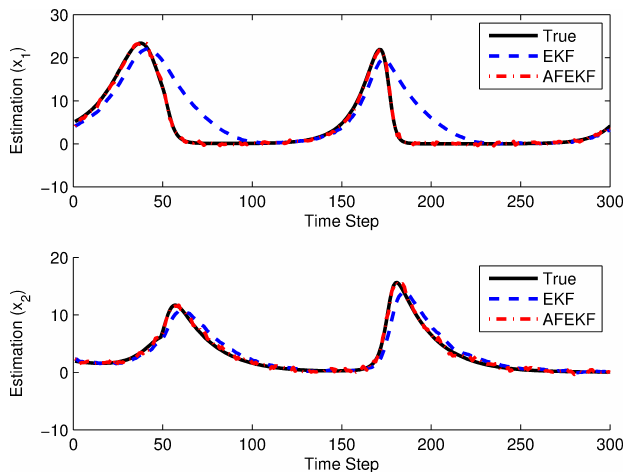
Fig. 3. State 1 and State 2 estimations (Stability conditions are